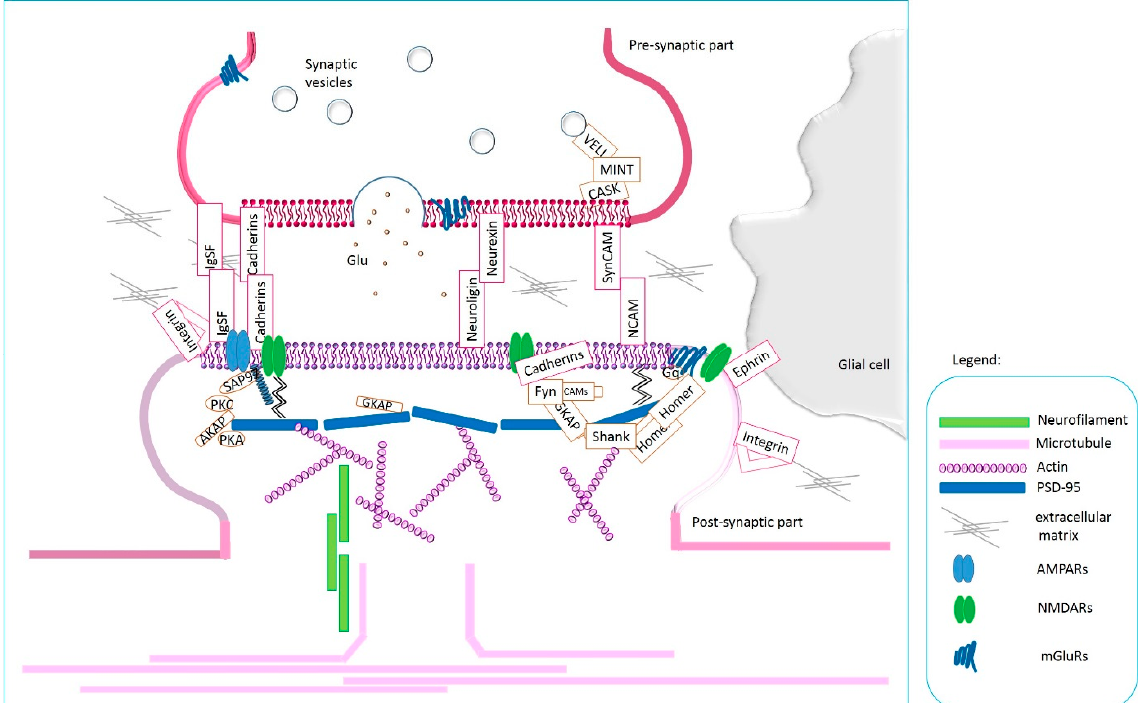
Figure 3. Adhesion at the synapse-a schematic picture showing the ways in which CAMs interact to form a mobile synapse.